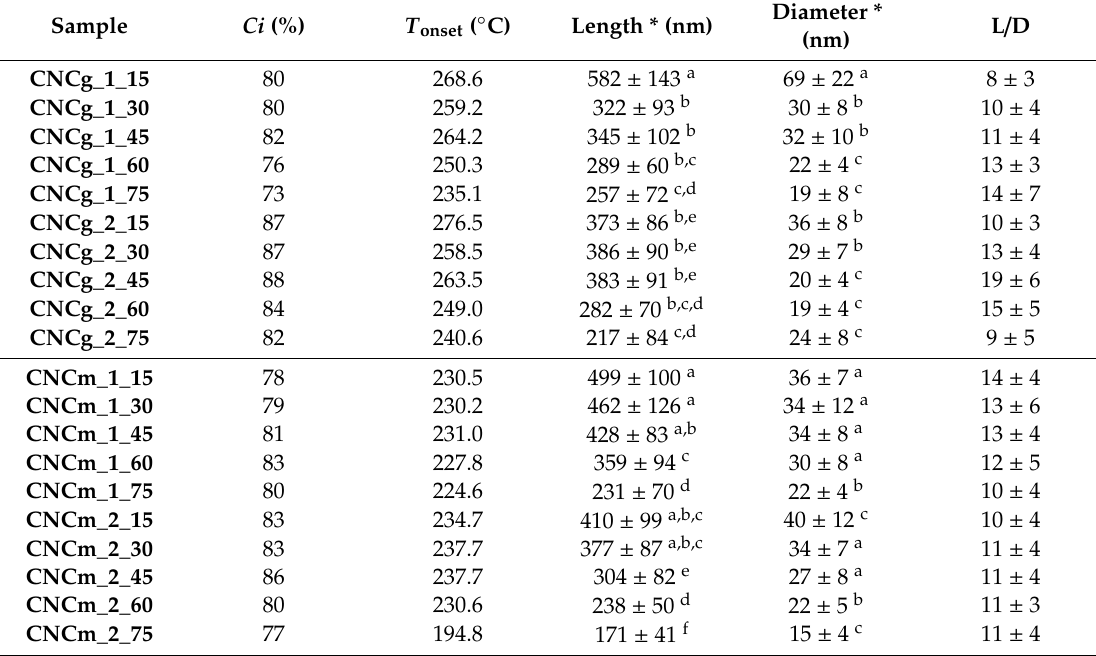
Table 4. Values of Ci, T onset and dimensions of